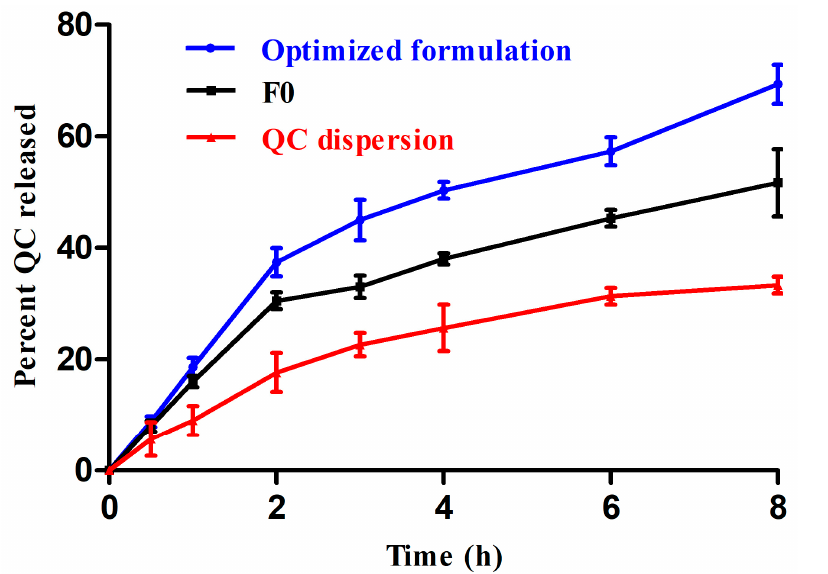
Figure 7. In vitro release patterns of QC from the optimized formula, F0 and QC dispersion (mean values ± SD, n = 3). Table 7. Fitting of release data with different kinetic models.